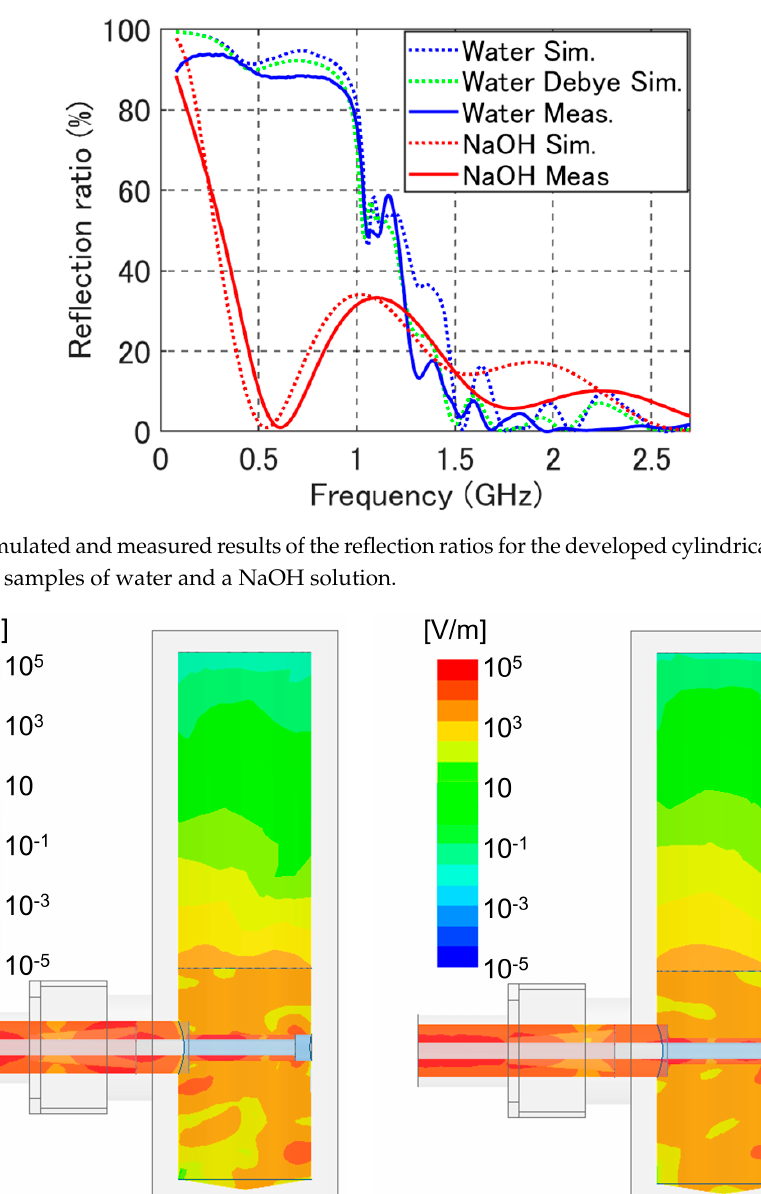
( d ) Figure 7. Simulated electric field distribution in the cylindrical applicator using liquid samples of water at ( a ) 2.45 GHz and ( b ) 1.7 GHz, and a NaOH solution at ( c ) 2.45 GHz and ( d ) 1.7 GHz.